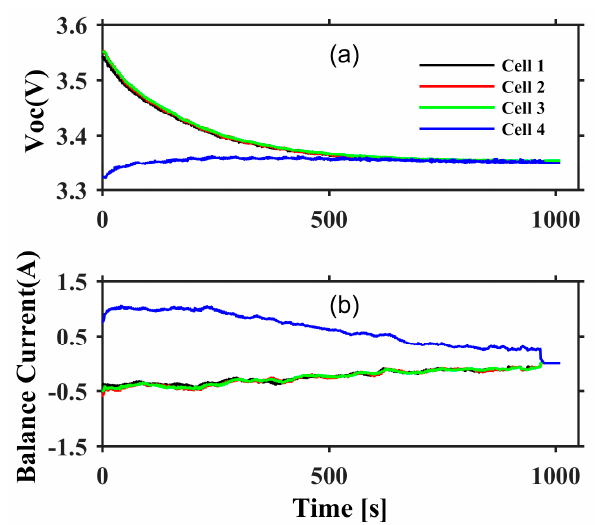
Figure 14. Experimental results for the LiFePO 4 battery pack with an FL controller. ( a ) OCV for each cell; ( b ) average balancing current for each cell.